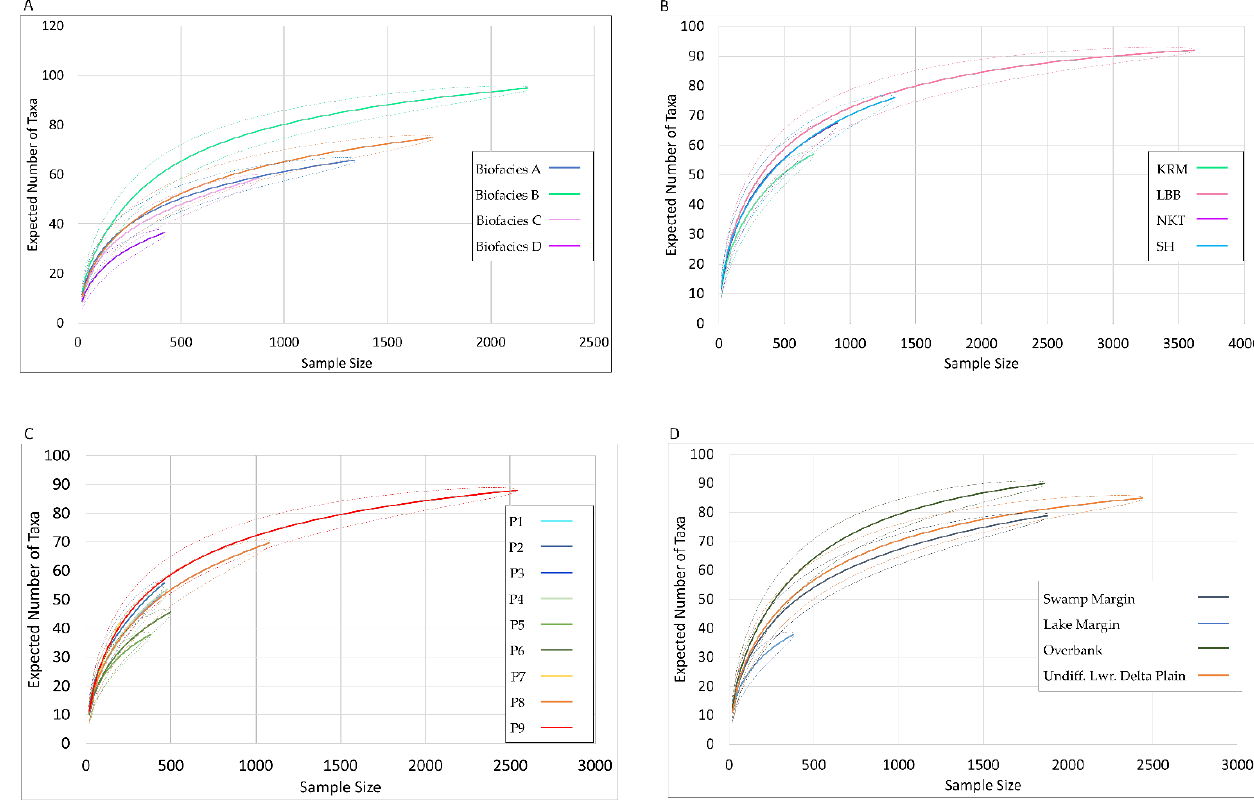
Figure 6. Comparison of taxonomic diversity among: ( A ) biofacies; ( B ) localities); ( C ) paleosol horizons; and ( D ) environ- ments using . Dashed lines are 95% confidence limits around the expected number of taxa.